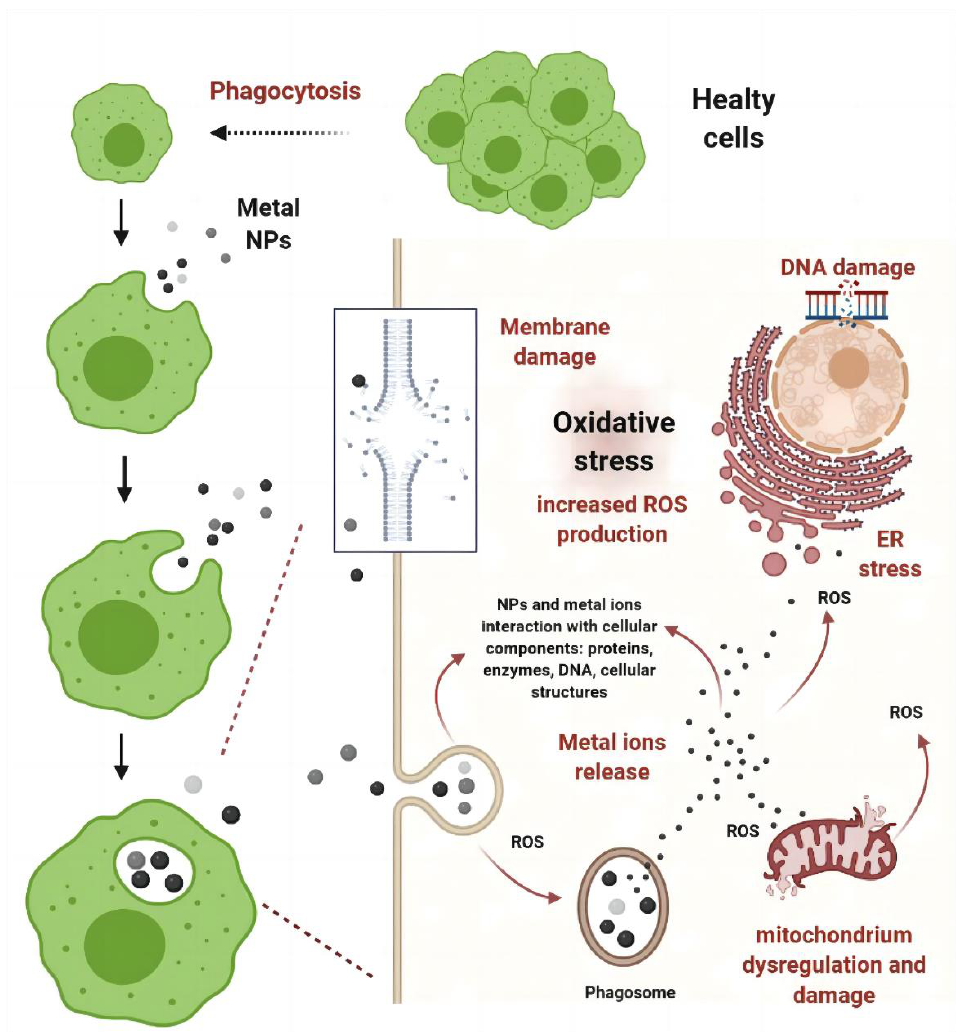
Figure 3. Oxidative stress and inflammation from phagocytosed metallic NPs leading to cell death. Reprinted with permission from ref [41]. 2021 Elsevier Ltd. Table 2. Common metal nanomaterials used in coatings.